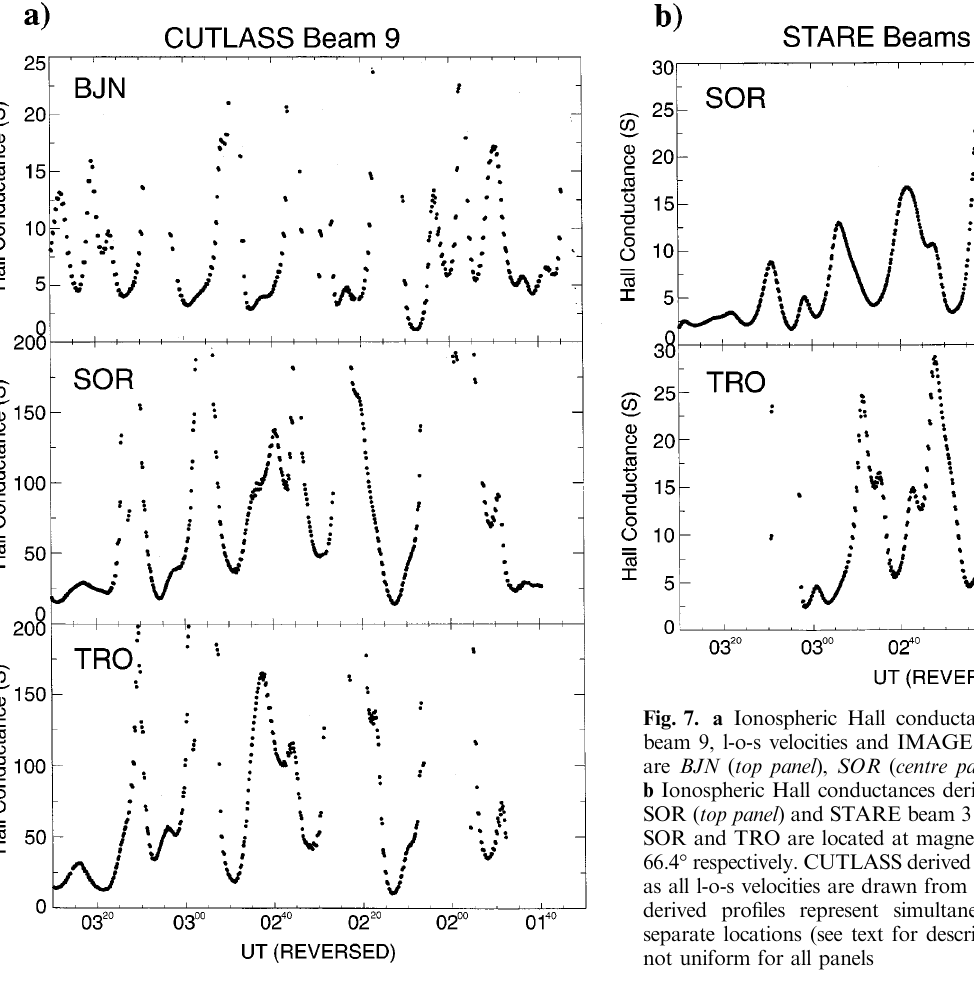
Fig. 6. Line-of-sight velocities from beam 9 of the CUTLASS Finland radar as a function of magnetic latitude and time ( bottom panel ). Equivalent current patterns deduced from SOR and BJN are overlaid at appropriate latitudes. Filtered magnetometer Y compo-